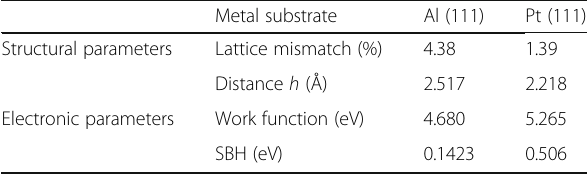
Table 1 Lattice mismatch was calculated using the lattice constant of MoS 2 ( a = 5.514 Å). Distance h is the difference between the averaged z -position values of S and Al at the interface. Work function was computed by the equation, W = E fermi − ϕ vac , E fermi is the Fermi energy of the total system (MoS 2 + metal substrate), and ϕ vac is the vacuum potential of the system. SBH was calculated as mentioned in the legend of Fig. 3 Al